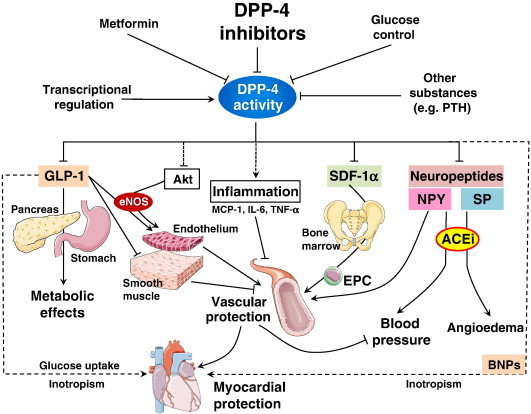
Cardiovascular effects of DPP-4 inhibitors [27].